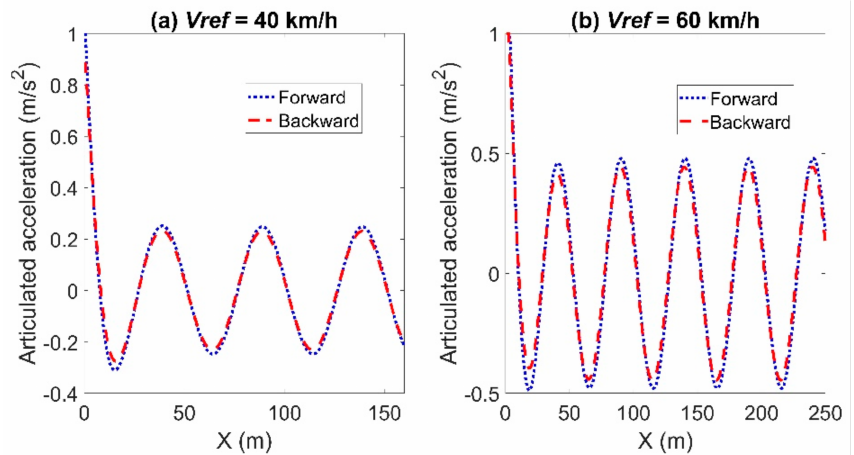
Figure 6. Articulated acceleration for the comparison between the forward and backward Euler method: left for Case ( a ) with Vref = 40 km/h and right for Case ( b ) with Vref = 60 km/h.